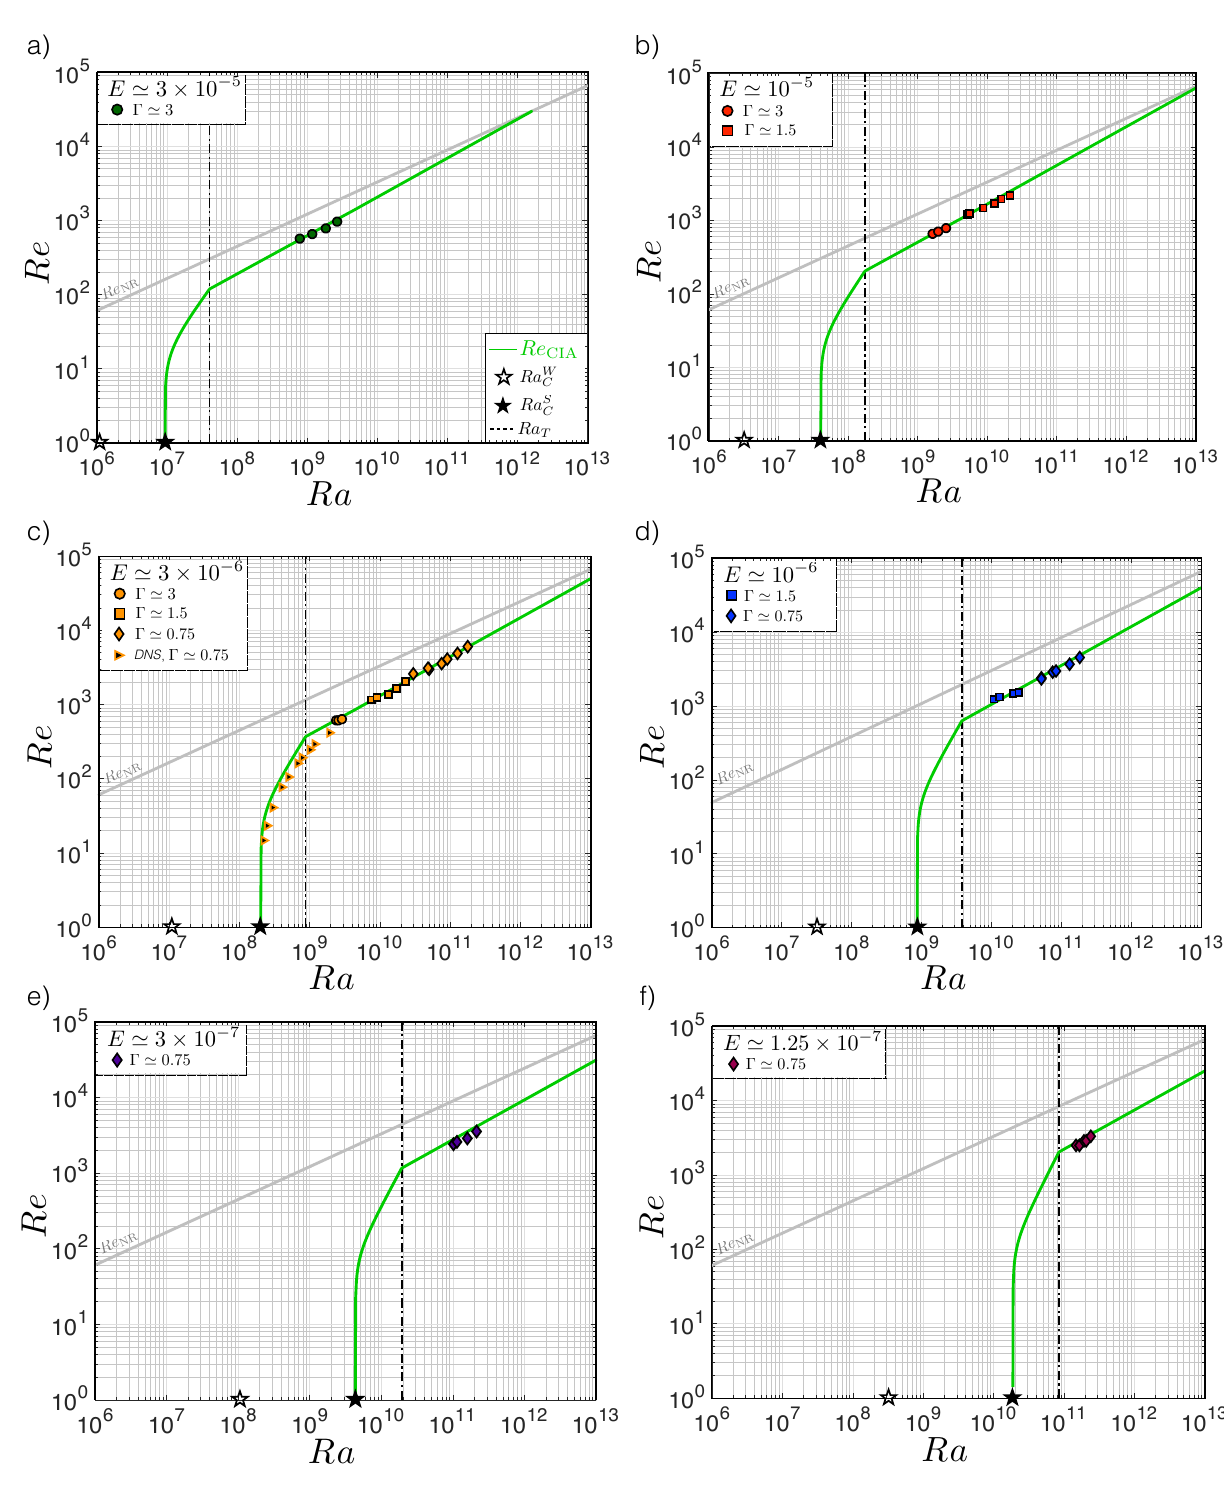
Figure 7. Re vs. Ra for each fixed E dataset collected in this study. ( a ) E 3 10 − 5 (forest green), (cid:39) × ( b ) E 10 − 5 (red), ( c ) E 3 10 − 6 (orange), ( d ) E 10 − 6 (blue), ( e ) E 3 10 − 7 (purple), and (cid:39) (cid:39) × (cid:39) (cid:39) × ( f ) E 1.25 10 − 7 (burgundy). Symbol shape represents the experimental container used/simulated, (cid:39) × consistent with Figure 5b. The theoretical scaling curves from Figure 2d at each respective fixed E value are plotted in each panel, where the green curves are given by Re CIA = ( Ra ( Nu 1 ) / Pr 2 ) 2/5 E 1/5 . − Ra T , Nu Ω from Figure 5a is used in the calculation of these green curves, and above Below Ra ≤ Ra > Ra T , Nu 0 is assumed. For each fixed E dataset, good agreement with CIA theory (green curve) is